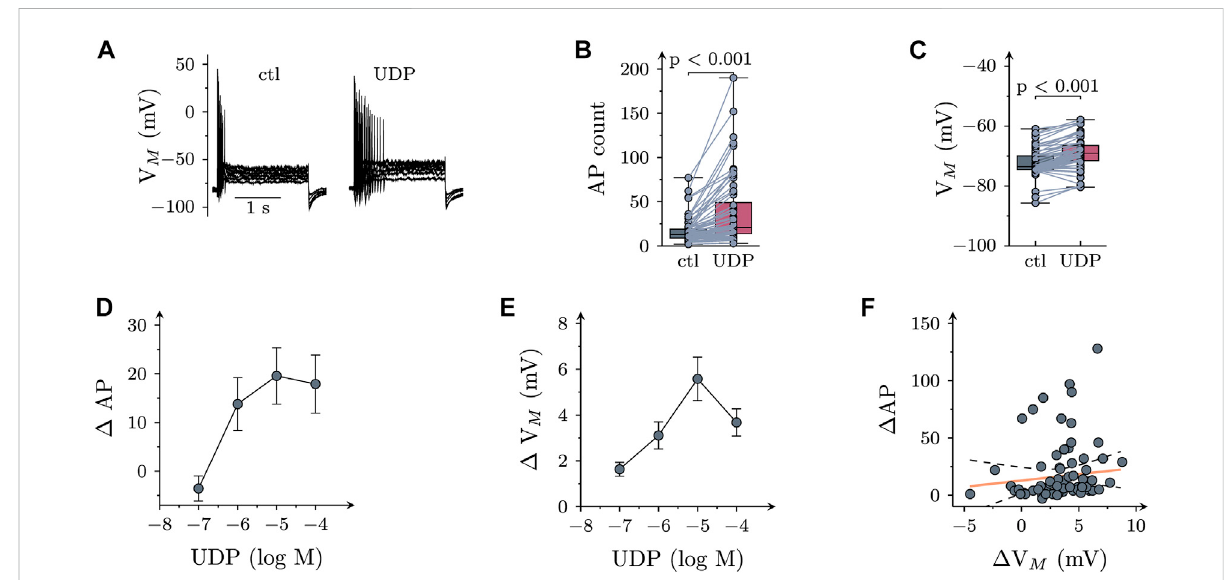
FIGURE 1 Effects of UDP on sympathetic neuron excitability. Membrane potential was measured in perforated-patch current clamp in single SCG neurons,and6depolarizing 2 scurrentswithamplitudesof50,100,150,200,250,and300 pAwereinjectedtotriggeractionpotentials. (A) Original current clamp traces obtained from a SCG neuron before (ctl) and 120 s after application of 10 µM UDP. (B) Numbers of action potentials (AP count) fi red in response to current injection before (ctl) and during the presence of UDP (10 μ M; n = 66); p values were obtained by a Wilcoxon matched-pairs signed rank test. (C) Resting membrane potential (V m ) determined before (ctl) and during the presence of UDP (10 μ M; n = 66); p values were obtained by a Wilcoxon matched-pairs signed rank test. (D) Concentration dependence of changes in action potential fi ring ( Δ AP) in presence of UDP ( n = 9). (E) Concentration dependence of changes in resting membrane potential ( Δ V m ) in presence of UDP ( n = 9). (F) Correlation between changes in resting membrane potential ( Δ V m ) and action potential fi ring ( Δ AP) for the neurons shown in B & C ( n = 66; r 2 = 0.022; slope = 1.65 ± 1.38; p = 0.24 vs. slope =